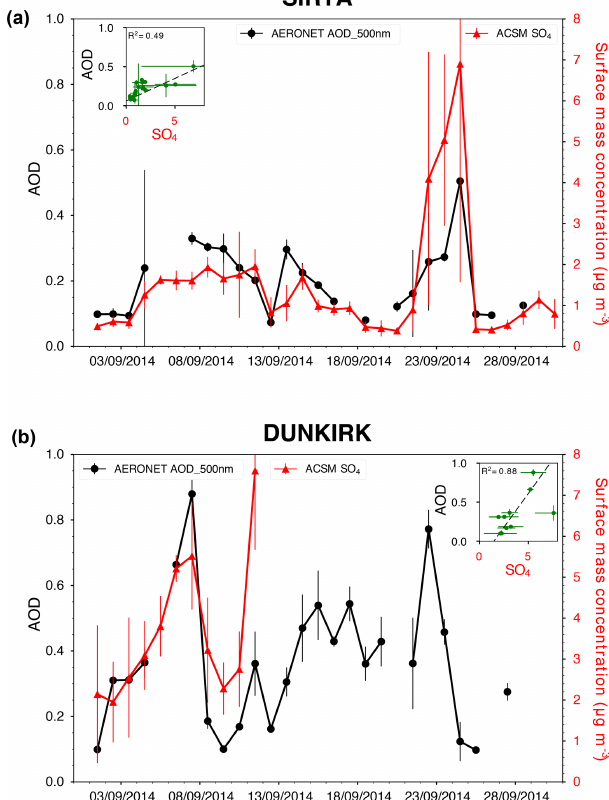
Figure 12. Time series of daily averaged values of both AERONET AOD at 500nm and ACSM SO 4 mass concentration, with vertical bars indicating the dispersion of data over 24h, at (a) SIRTA and (b) Dunkirk. In inset are included scatter plots and associated deter- mination